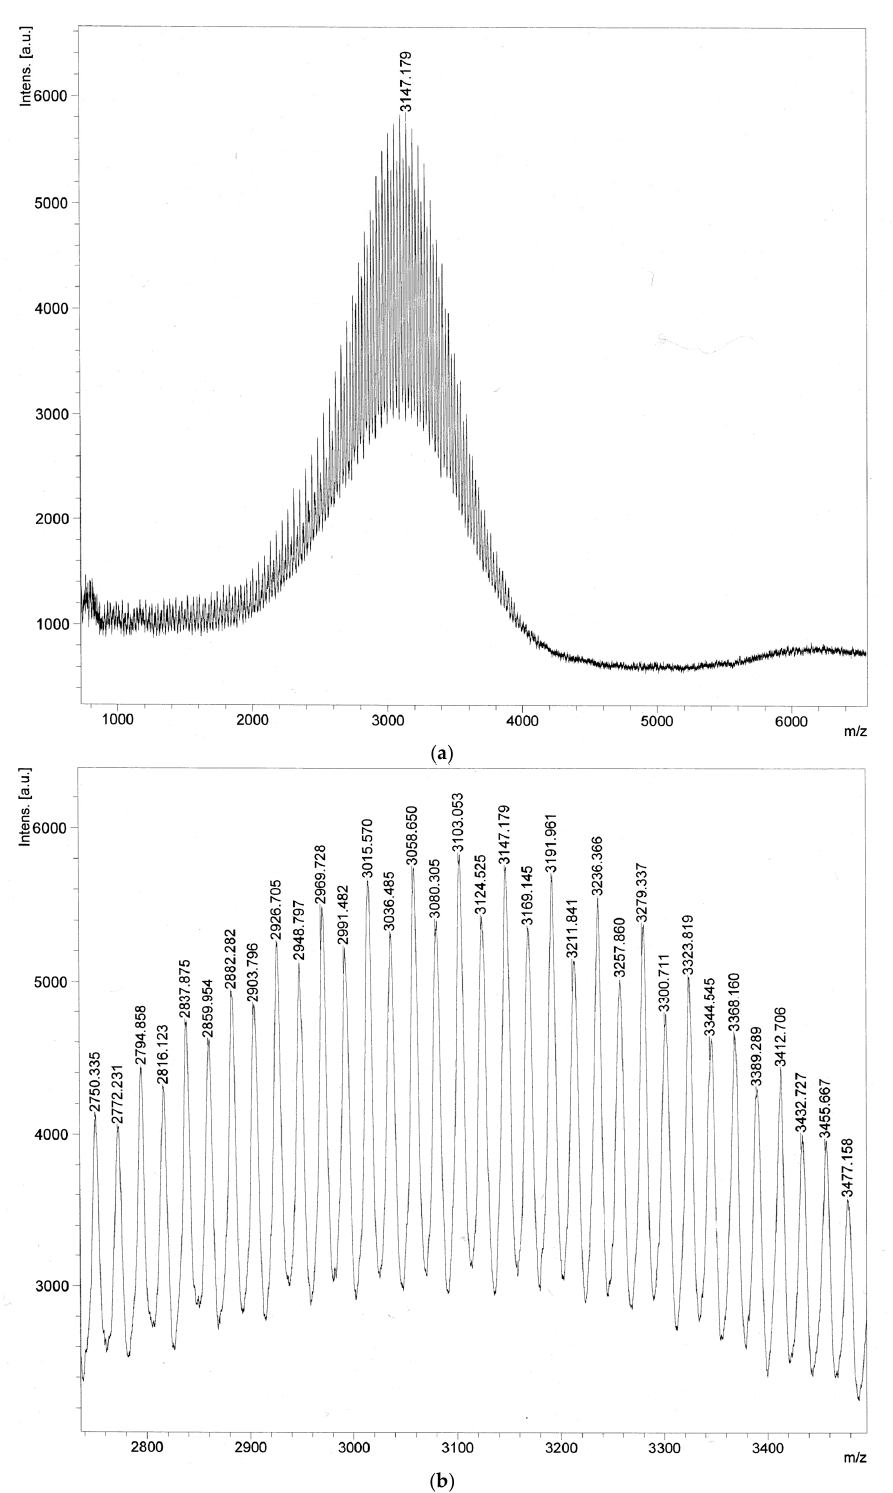
Figure 2. MALDI-TOF-MS spectra of PBL: ( a ) General view; ( b ) enlarged view. Signal intensities are given in arbitrary units [a.u.].